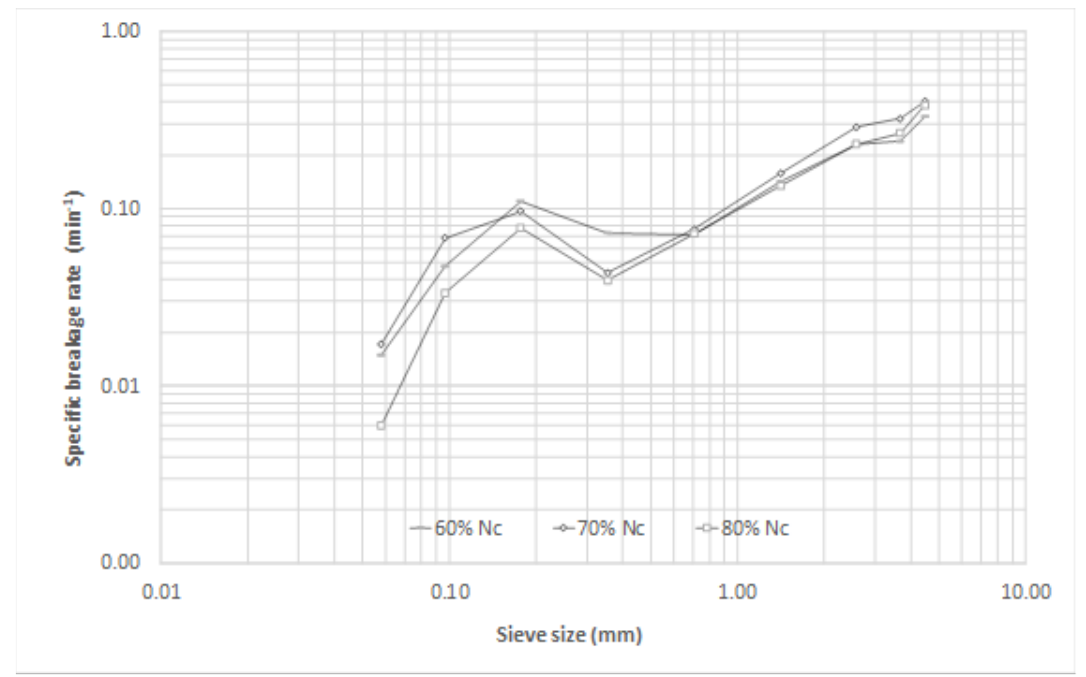
Figure 2. Evolution of the probability of fracture ( S i ) with particle size, in relation to mill speed.